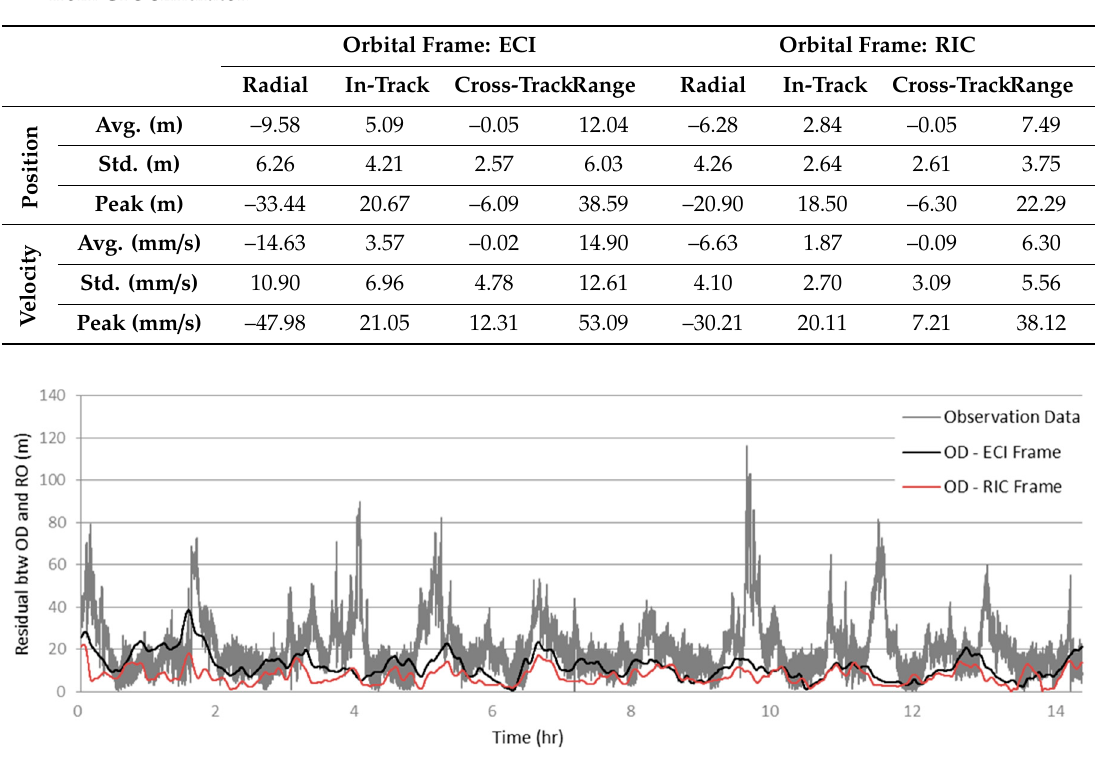
Figure 7. Superiority and inferiority of the orbital frame when orbit determination logic is performed. The accuracy of orbit determination logic improved after applying the RIC frame, and local maximum errors that are seriously affected by ionospheric time delay were also reduced.